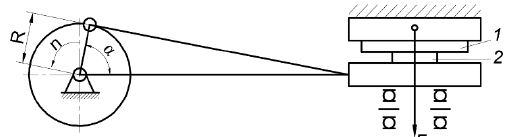
Fig. 1. Kinematic diagram of the friction unit 1 - counterbody, 2 - test